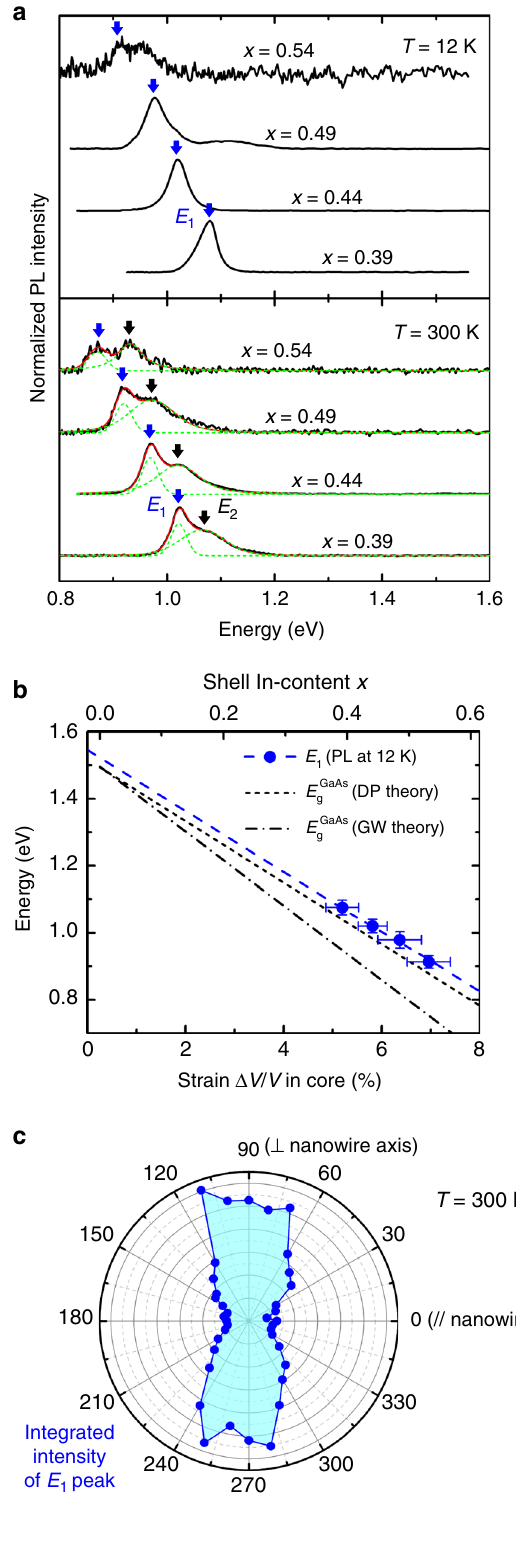
Fig. 5 Effect of strain on the bandgap energy of the core in GaAs/In x Al 1 − x As core/shell nanowires with shell thickness L S = 80 nm. a Photoluminescence (PL) spectra as measured on ensembles of nanowires with different x at 12 and 300 K. The spectra have been shifted vertically for the sake of clarity. Fit curves (Voigt) are shown in green (contributing peaks) and red (cumulative curves). Primary ( E 1 ) and secondary ( E 2 ) emissions are indicated with blue and black arrows, respectively. b E 1 peak energy at 12 K (blue data points) as a function of the hydrostatic strain in the core (bottom x -axis) and the corresponding In-content x in the shell (top x -axis). The energy error bars correspond to the full-width at half-maximum of the PL fi t curves, whereas the strain error bars originate from the error bars in Raman scattering measurements. The blue dashed line is a linear fi t of the PL data. The black lines correspond to the bandgap energy of bulk GaAs as a function of strain, calculated with deformation potential theory (DP; dashed line) or from fi rst-principles (GW; dash-dotted line). c Integrated intensity of the E 1 peak in polarisation-resolved PL at 300 K. The polarisation of the excitation light was parallel to the nanowire axis (0° and